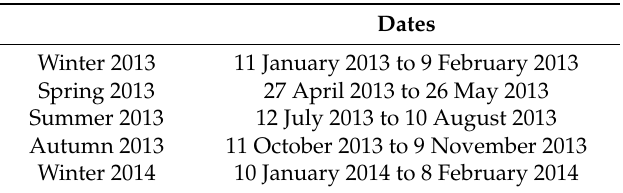
Table 2. Dates of five enhanced target periods.